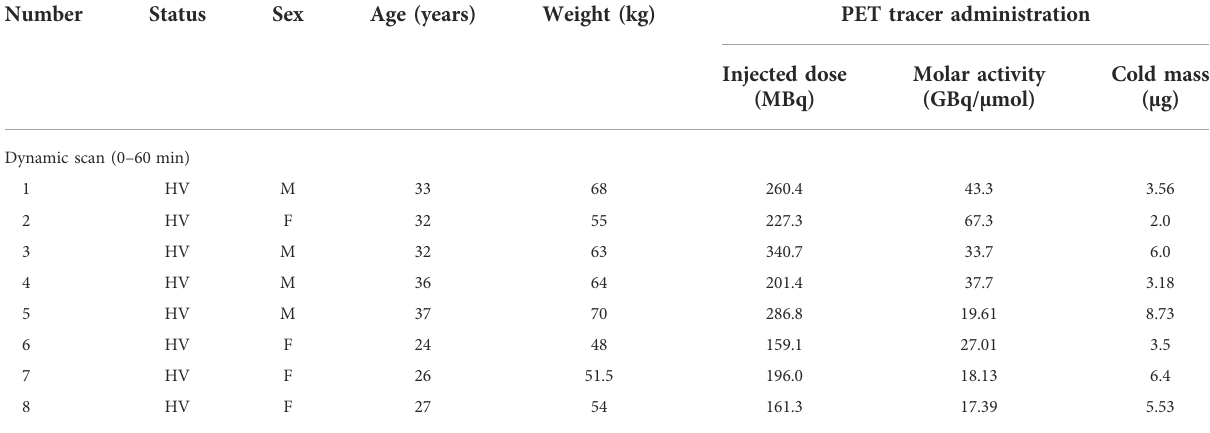
TABLE 2 Information of volunteers and administrations of [ 18